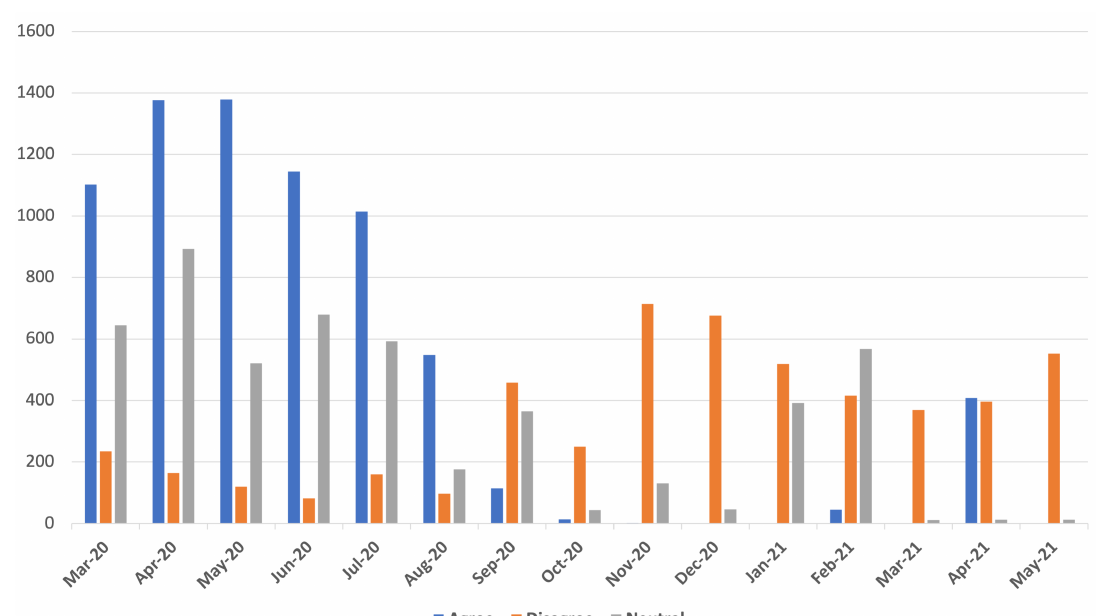
Figure 4. Frequency of tweets related to online education during the COVID-19 pandemic per month from March 2020 to May 2021.